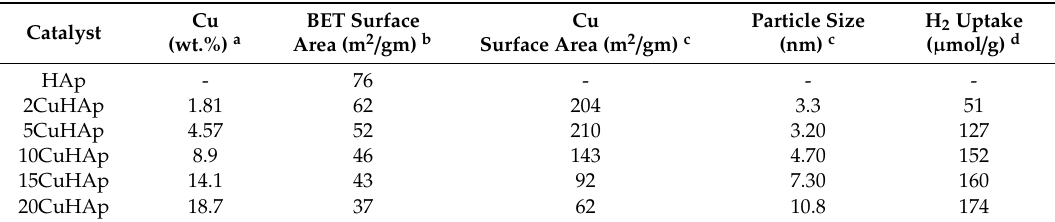
Table 1. Catalytic properties from ICP, BET, N 2 O titration and H 2 -TPR results of CuHAp catalysts with different Cu loadings were summarised.